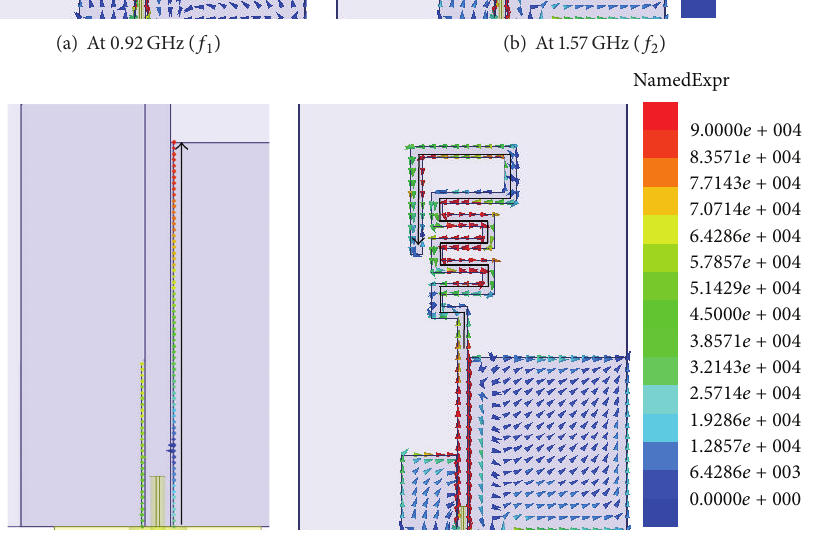
the meandered monopole trace. Their corresponding reso- nant lengths are 1/4, 3/4, and 5/4 wavelengths long. The